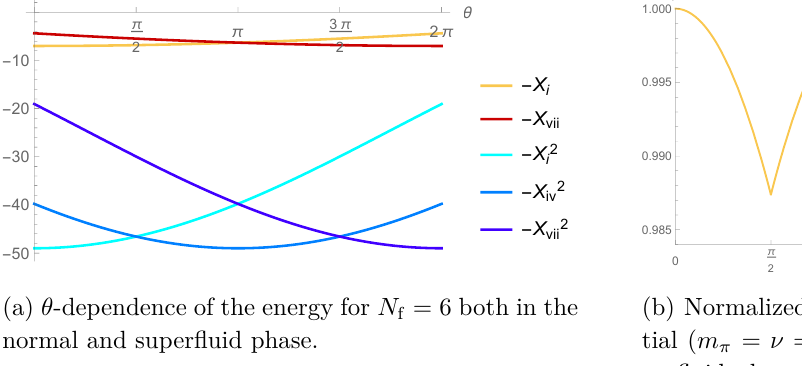
(a) θ -dependence of the energy for N = 6 both in the f normal and superfluid phase. Figure 8 . θ -dependence of the energy and of the critical chemical potential for N f = 7 . , α = θ +6 π , and α = θ +12 π α = θ 7 7